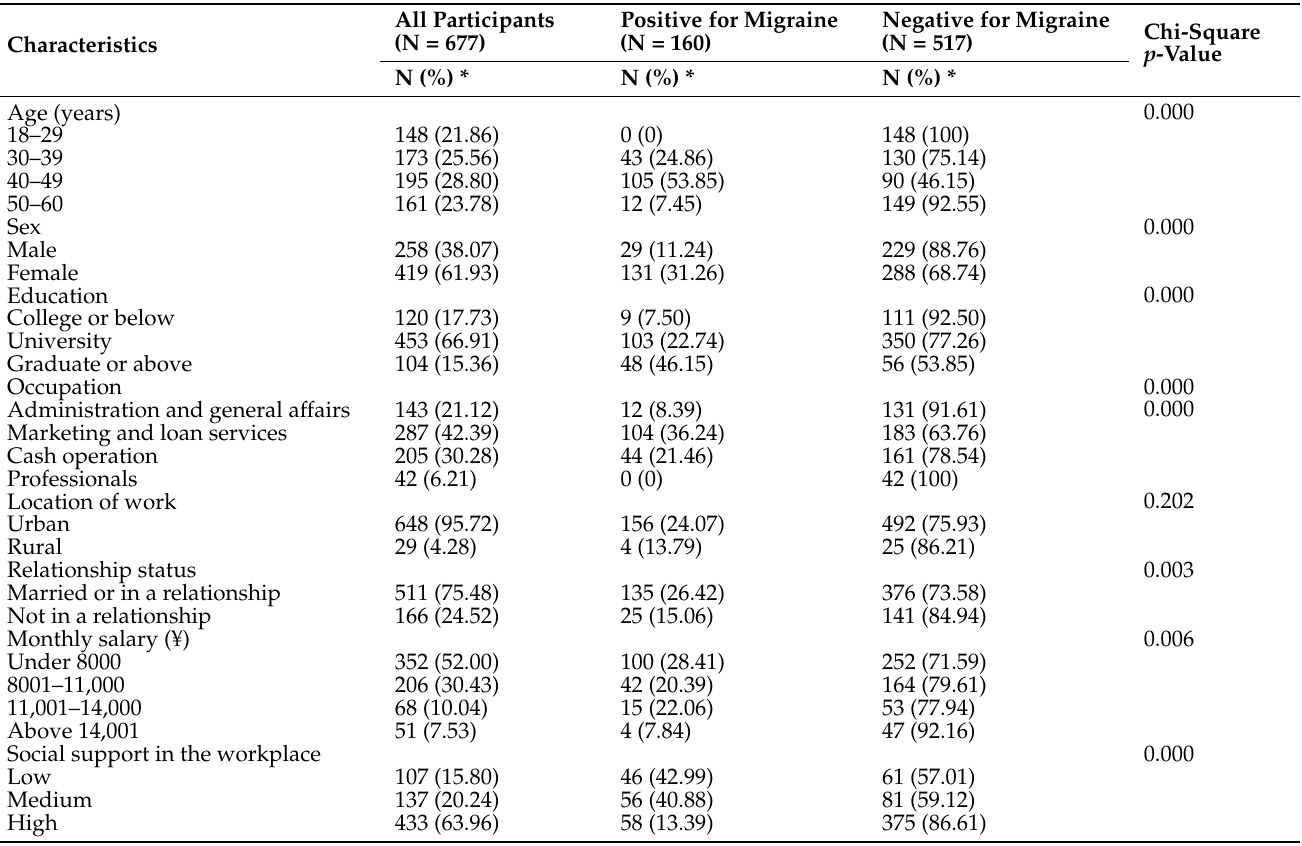
Table 1. Socio-demographic